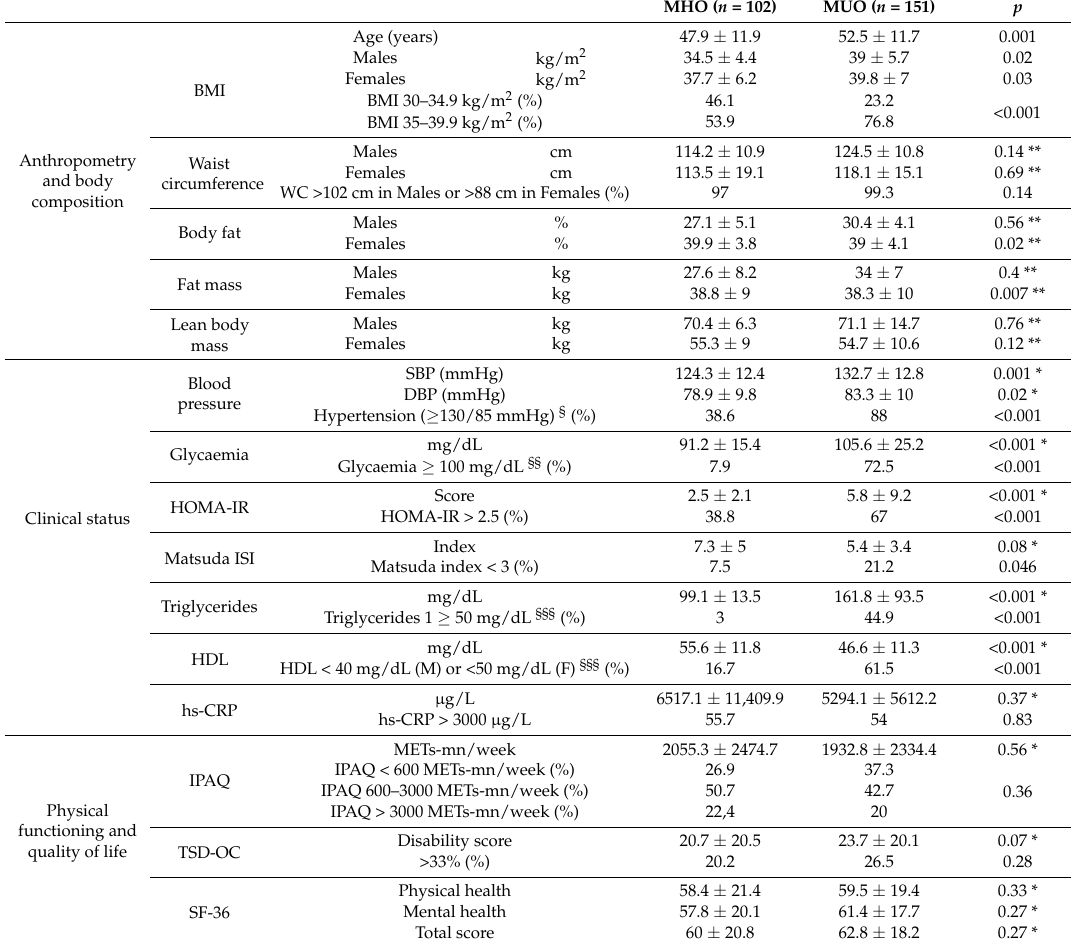
Table 1. Clinical and functional characteristics related to metabolic health of obese